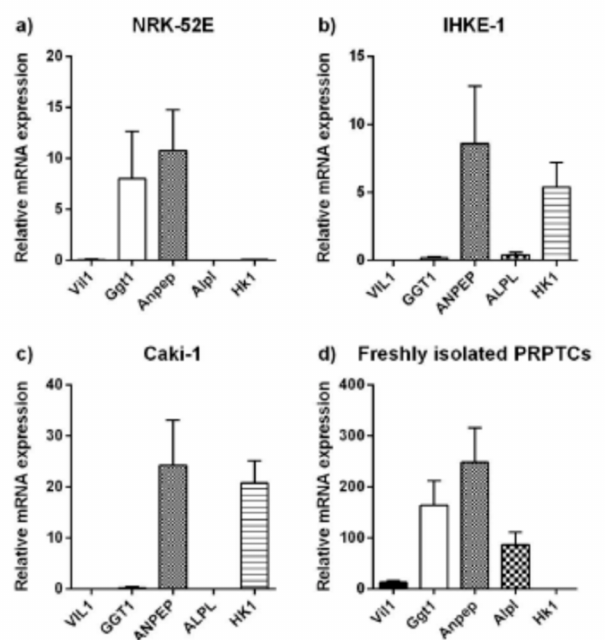
Figure 3. Relative mRNA expression of tubule marker proteins in the renal cell lines NRK-52E ( a ), IHKE-1 ( b ) and Caki-1 ( c ), and in freshly isolated PRPTCs ( d ). The mRNA expression of each gene was normalized to GAPDH/Gapdh expression. Each bar represents the mean ± SD ( n = 3).